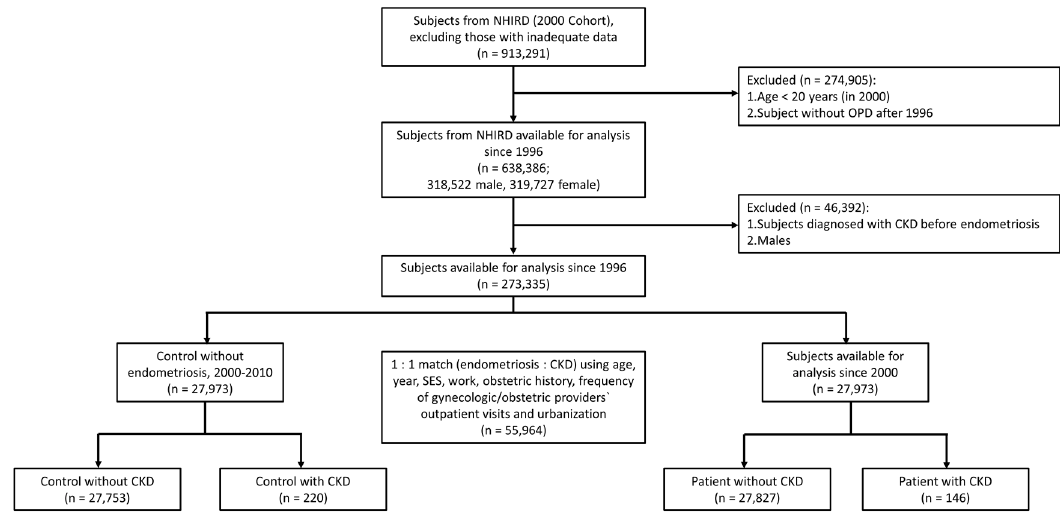
Figure 1. Cohort flow chart illustrating the inclusion and exclusion of participants in the study. NHIRD: National Health Insurance Research Database; OPD: outpatient clinics; CKD: chronic kidney disease.